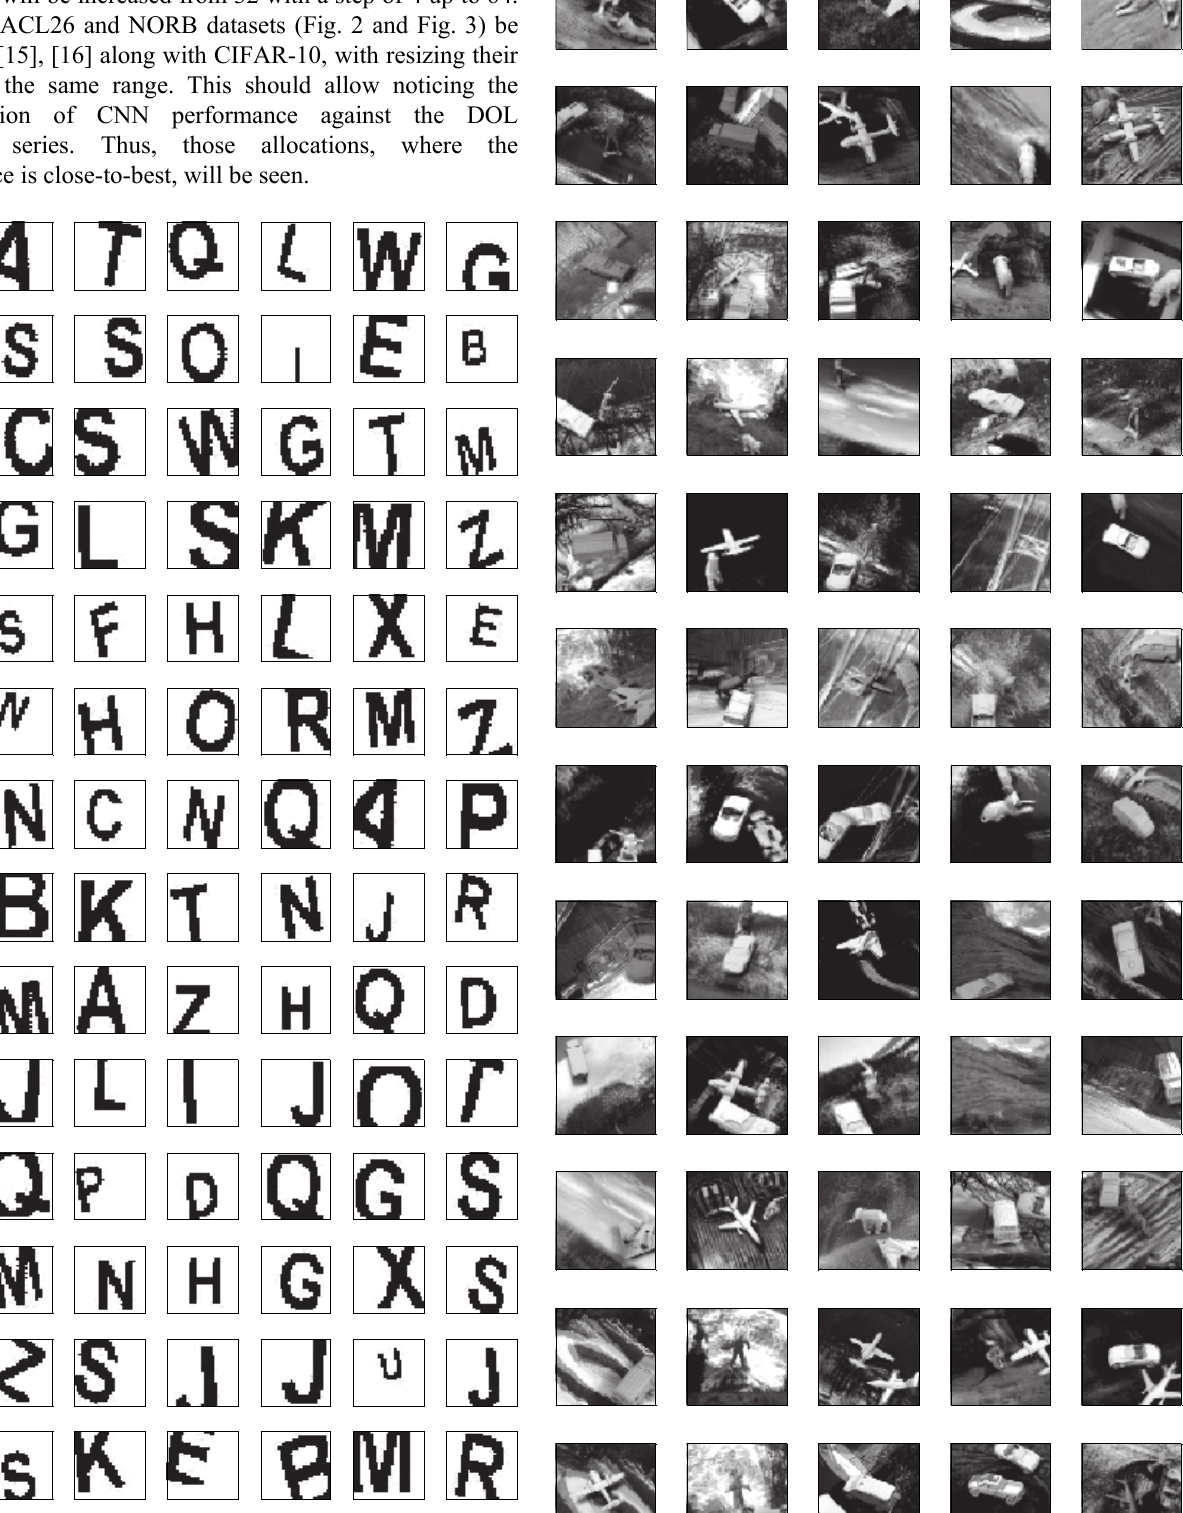
Fig. 3. The original NORB dataset contains grayscale 8-bit 108 × 108 × 2 images of 50 toys belonging to 5 generic categories (four-legged animals, human figures, airplanes, trucks, and cars), where the 6-th image category of the blank image is appended. The human eye can hardly recognise animals and human figures. Cars and trucks are almost